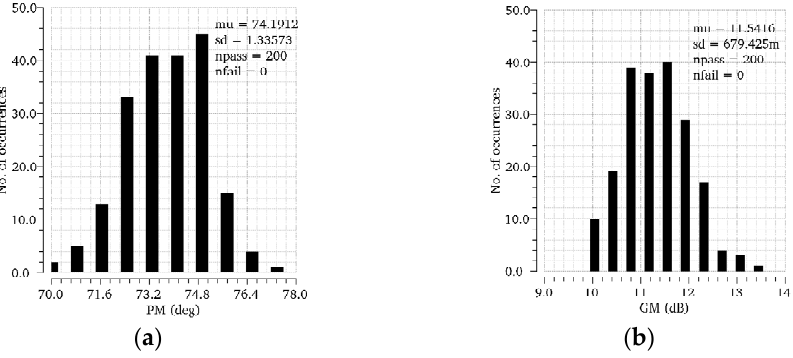
Figure 7. Simulated open − loop gain at different load currents with C L = 0.